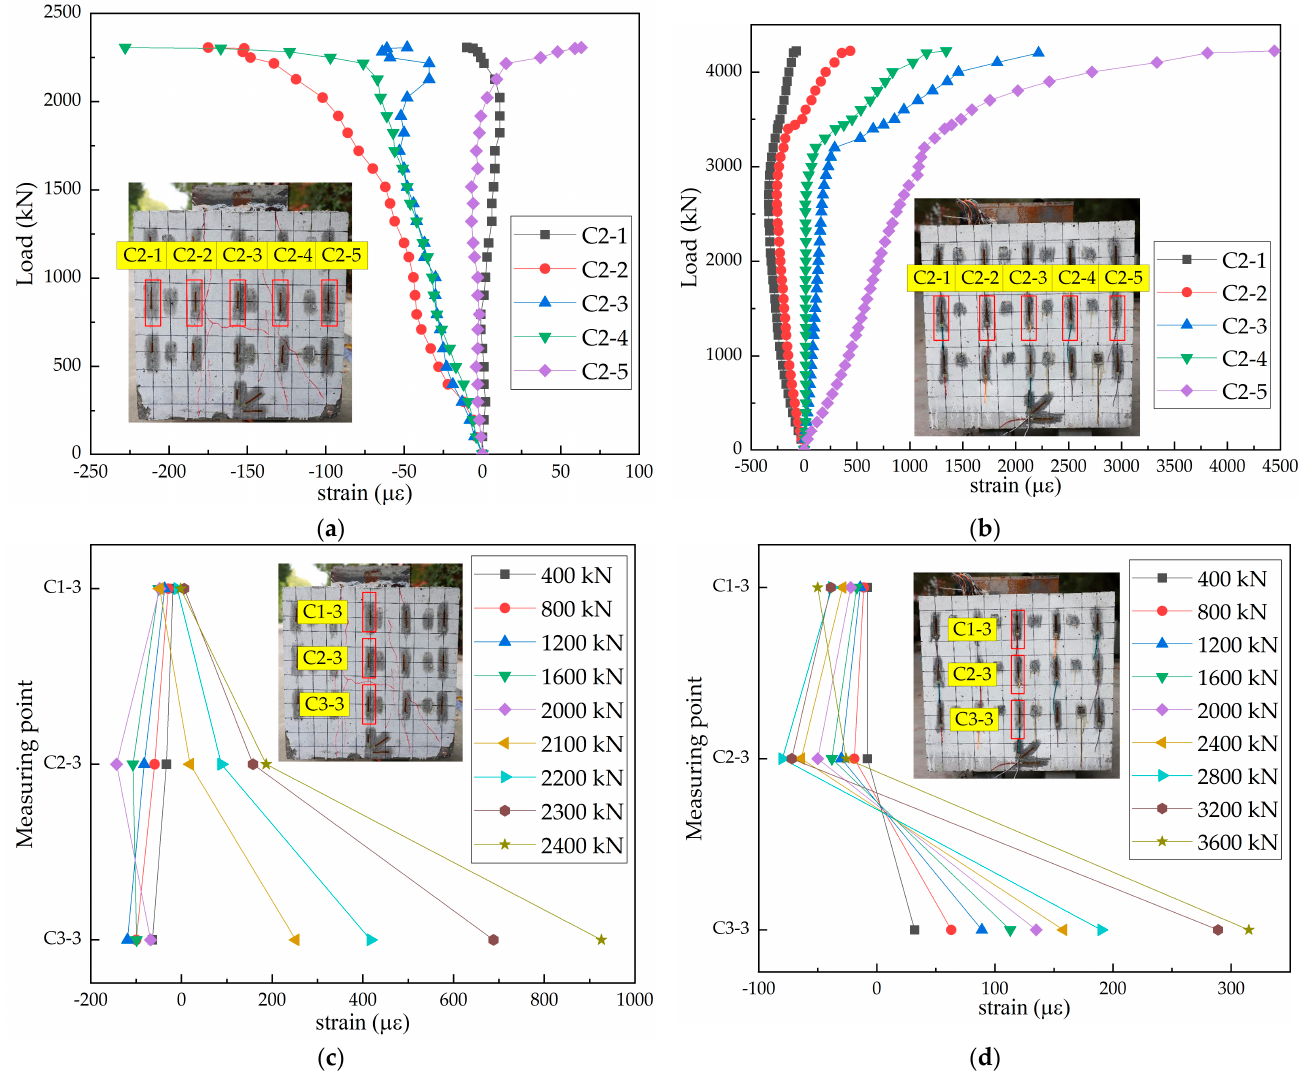
Figure 7. Load–strain curves of concrete: ( a ) N-20-3; ( b ) S-20-3; ( c ) N-20-3; and ( d ) S-20-3.